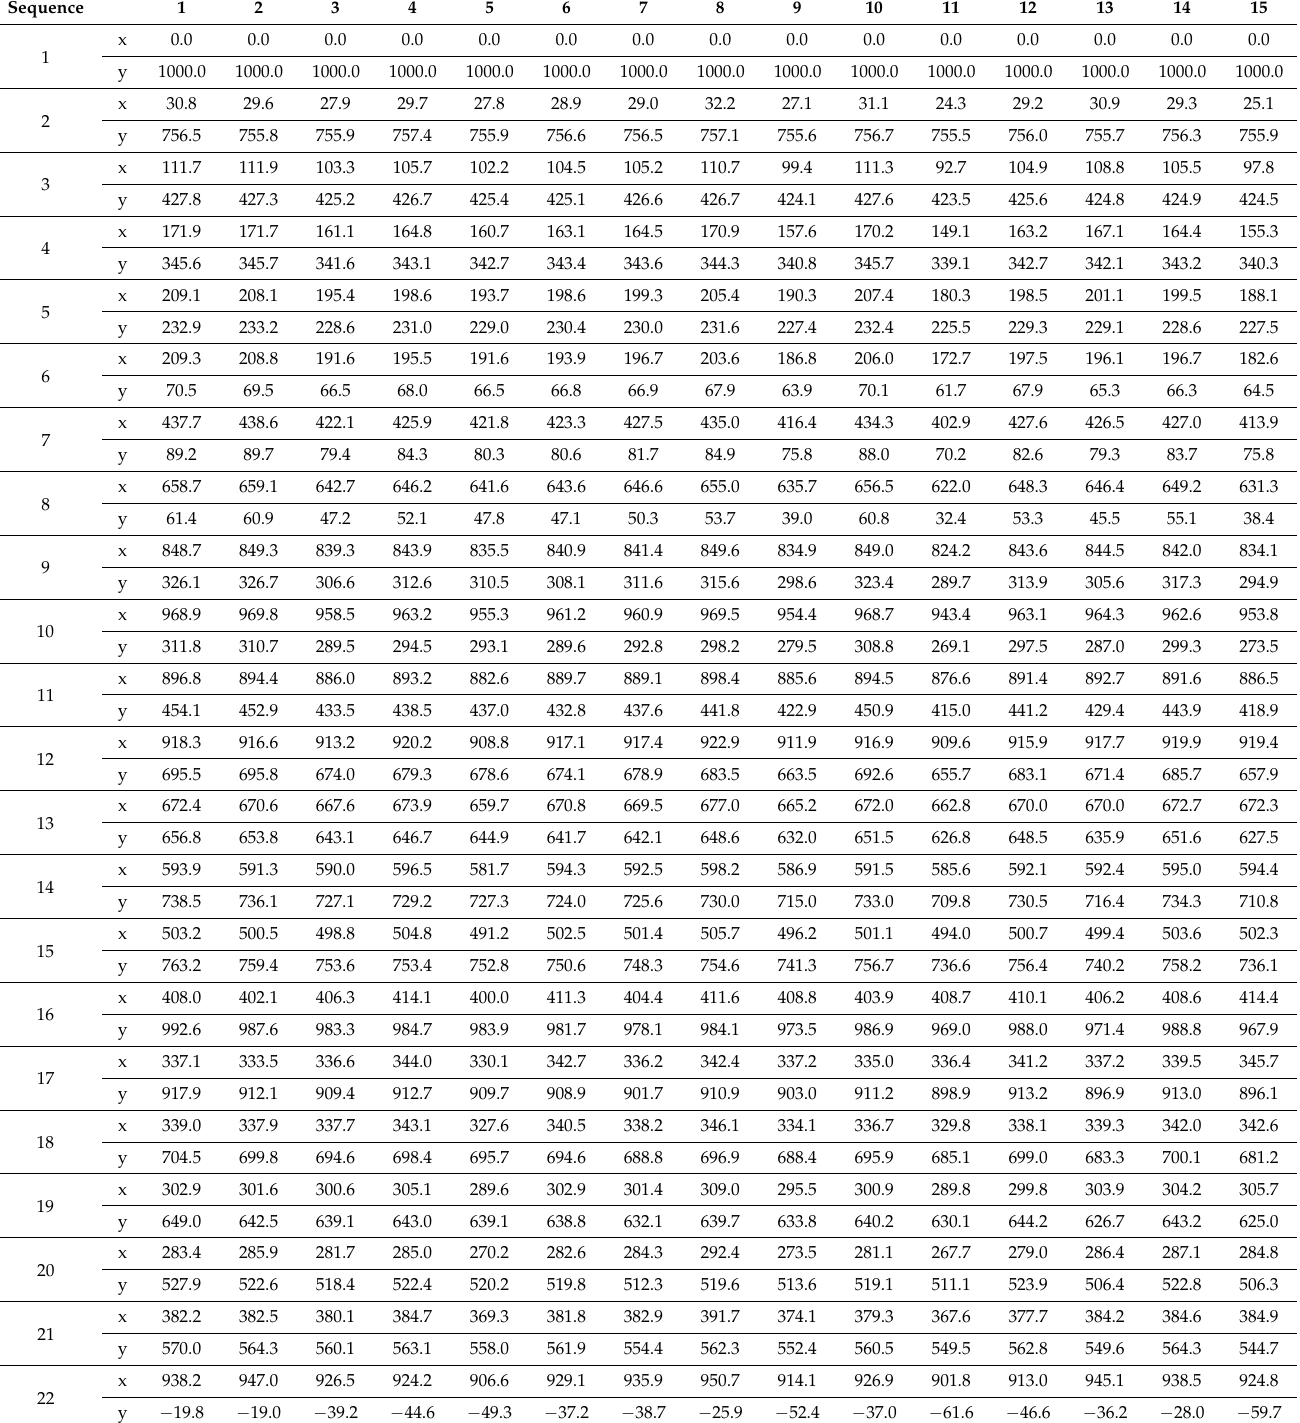
Table A5. Experiment data when moving along the path with the optimal precision. The movement commands have not been compensated